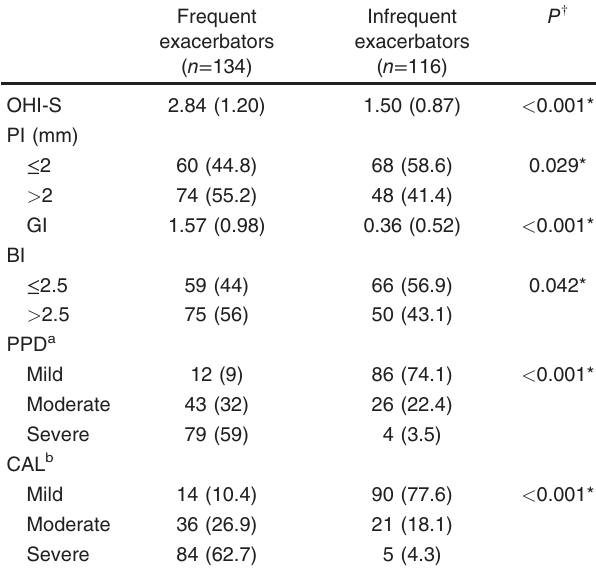
Table 2 Data description and comparisons between the two groups regarding periodontal health variables